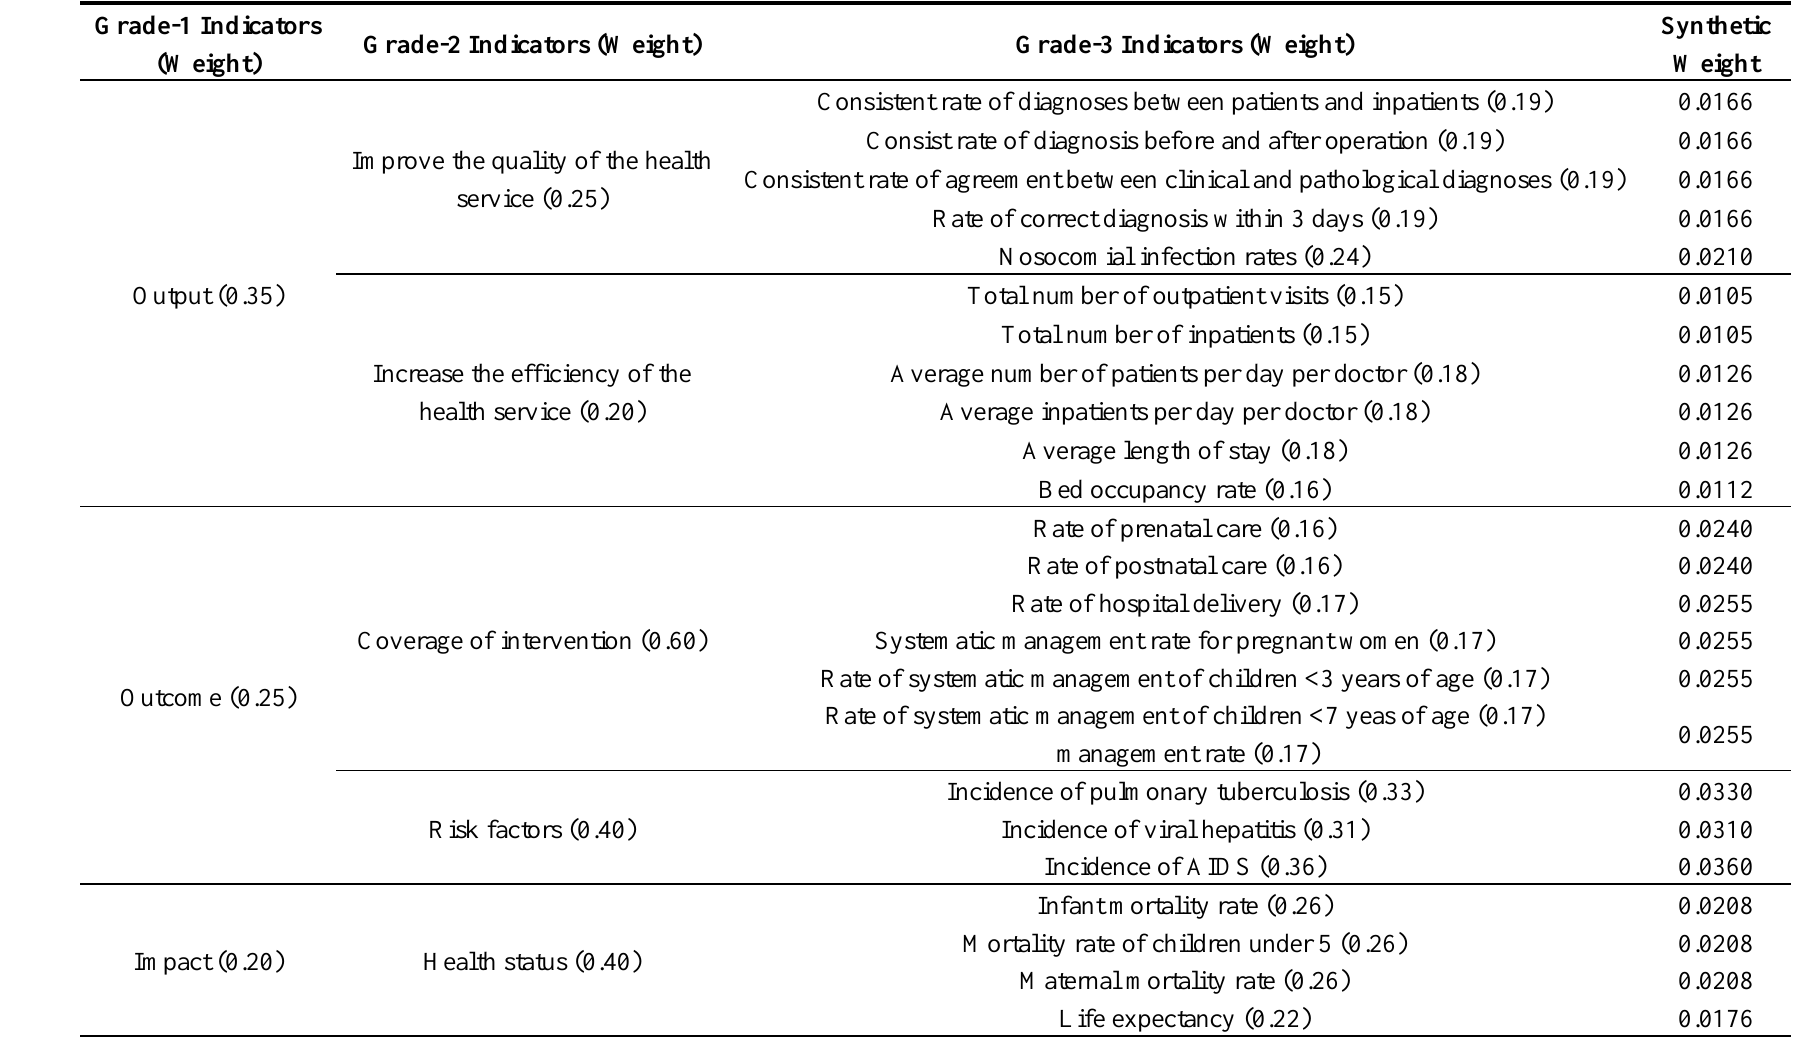
Table 3. Indicator system for healthcare